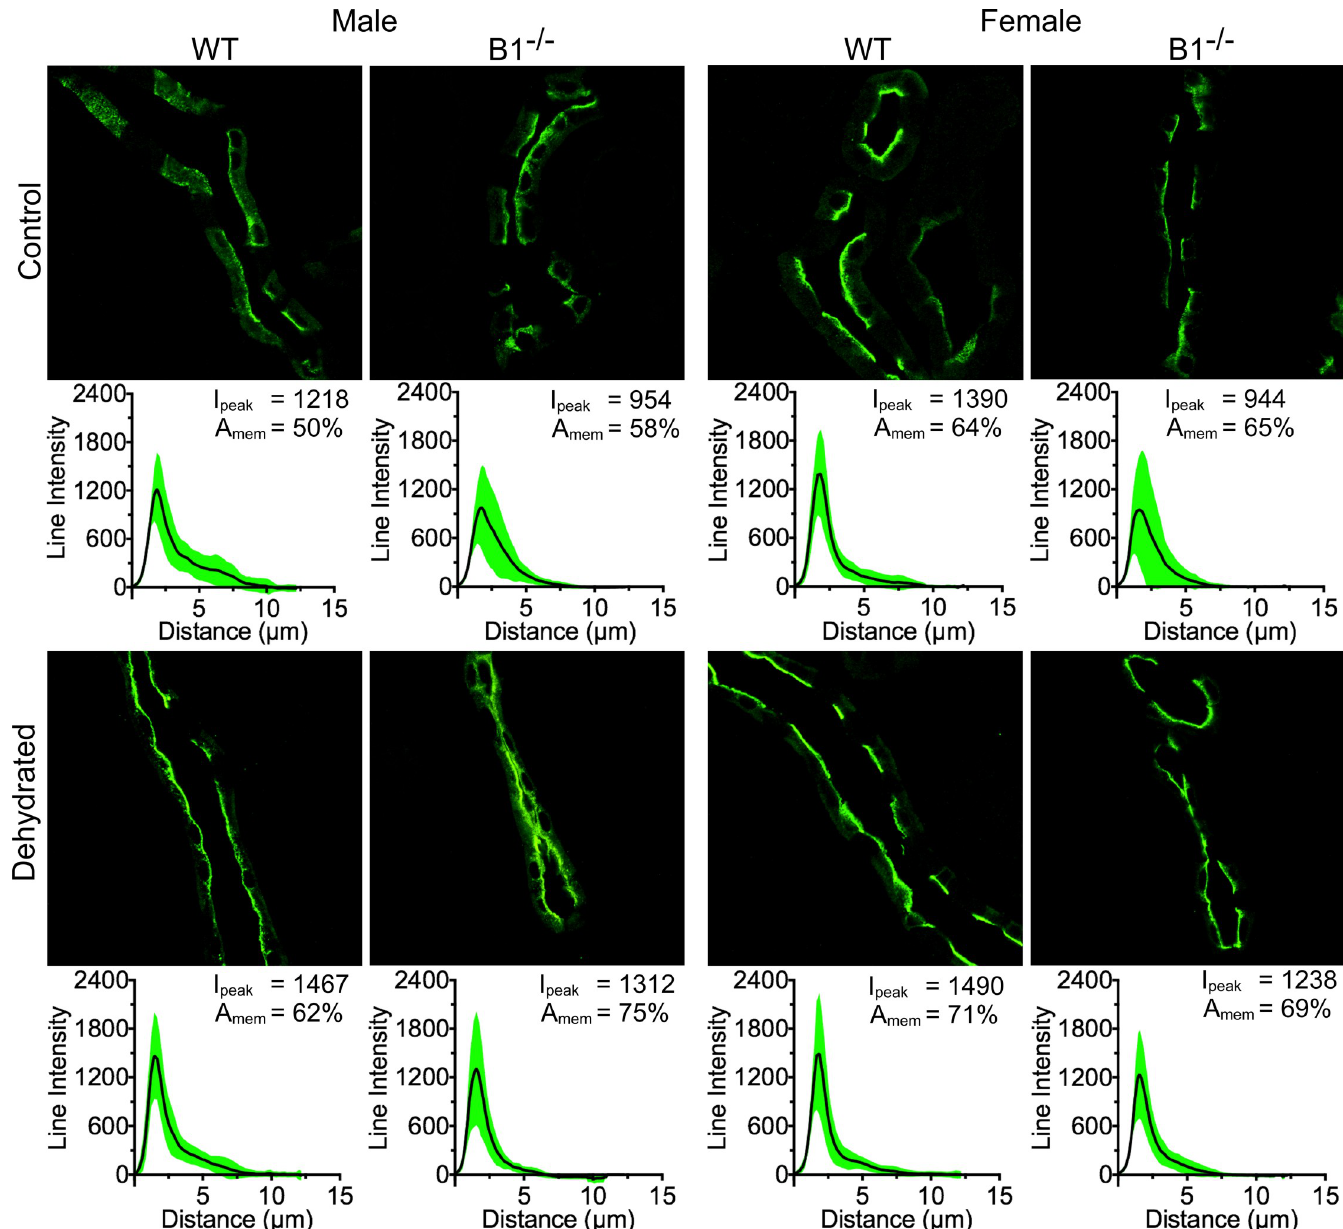
Fig 4. Male animals show the highest level of AQP2 regulation upon dehydration in the cortical collecting duct. Immunofluorescence imaging showing the distribution of AQP2 in the kidney principal cells (PCs). Under baseline conditions, AQP2 localization in the cortical collecting duct (CCD) PCs is sex-independent in both WT and Atp6v1b1-/- (B1 -/- ) mice. Upon dehydration AQP2 localization partially shifted towards the apical membrane. This effect was more pronounced in the male animals, of which B1 -/- mice showed the strongest response. Every panel has an average line intensity plot (black line) showing the distribution of protein within the cell. SD of the data is shown as a green area plot around the mean value plot. Peak intensity (I peak ) values and the total intensity distribution near the plasma membrane (A mem ) are also